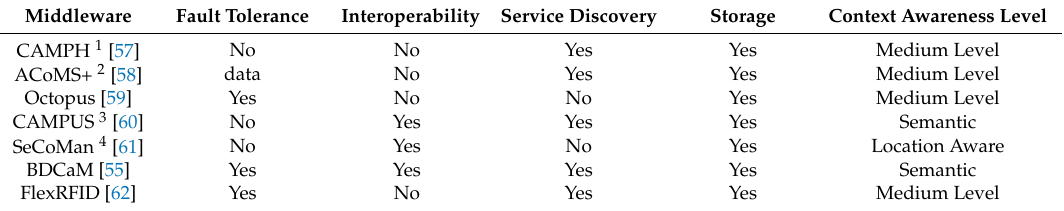
Table 1. Comparison of context aware middleware architectures shown in [41].